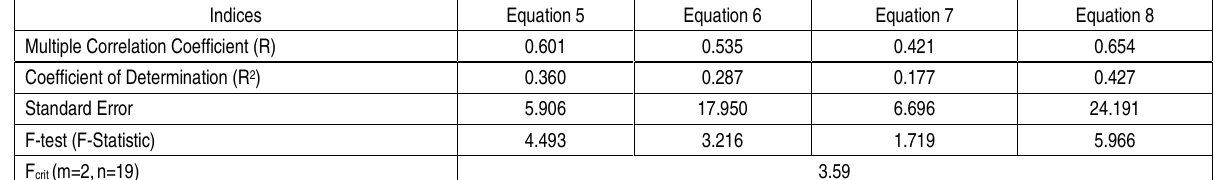
Table 2. Pilot parameters of Correlation Regressive Analysis over the period